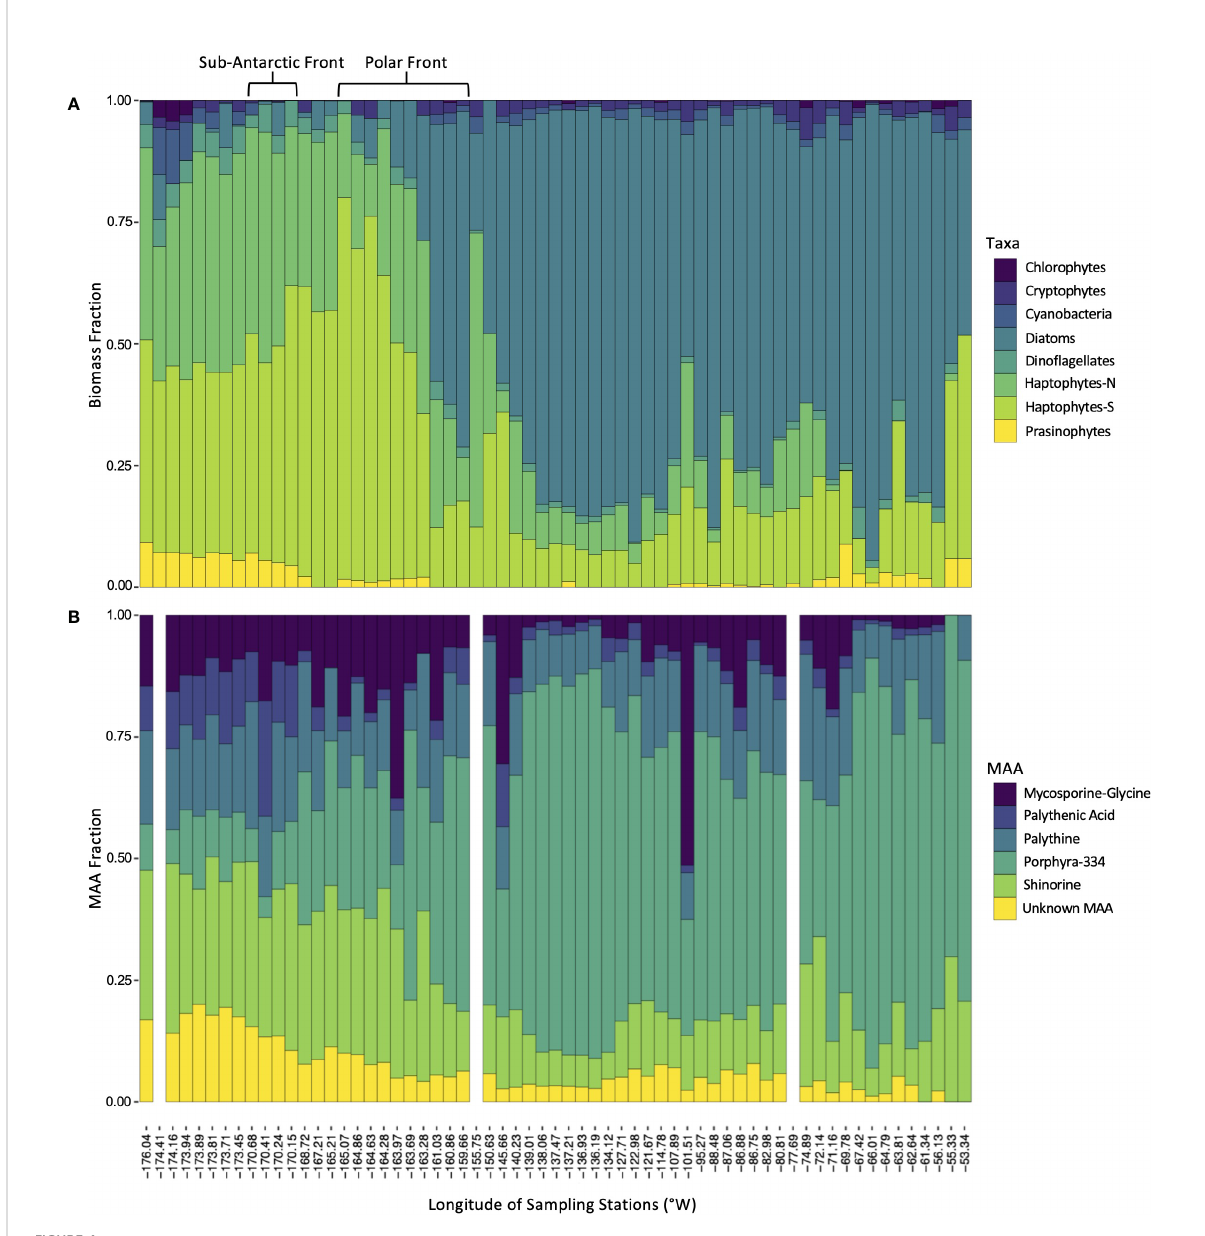
FIGURE 4 Distribution of phytoplankton taxa and mycosporine-like amino acids during ANA08D 2018 research expedition. (A) Estimated fraction of each taxonomic group to total biomass. (B) Fractional contribution of each dominant MAA to the total MAA pool. Blank columns indicate stations that were not sampled for MAA